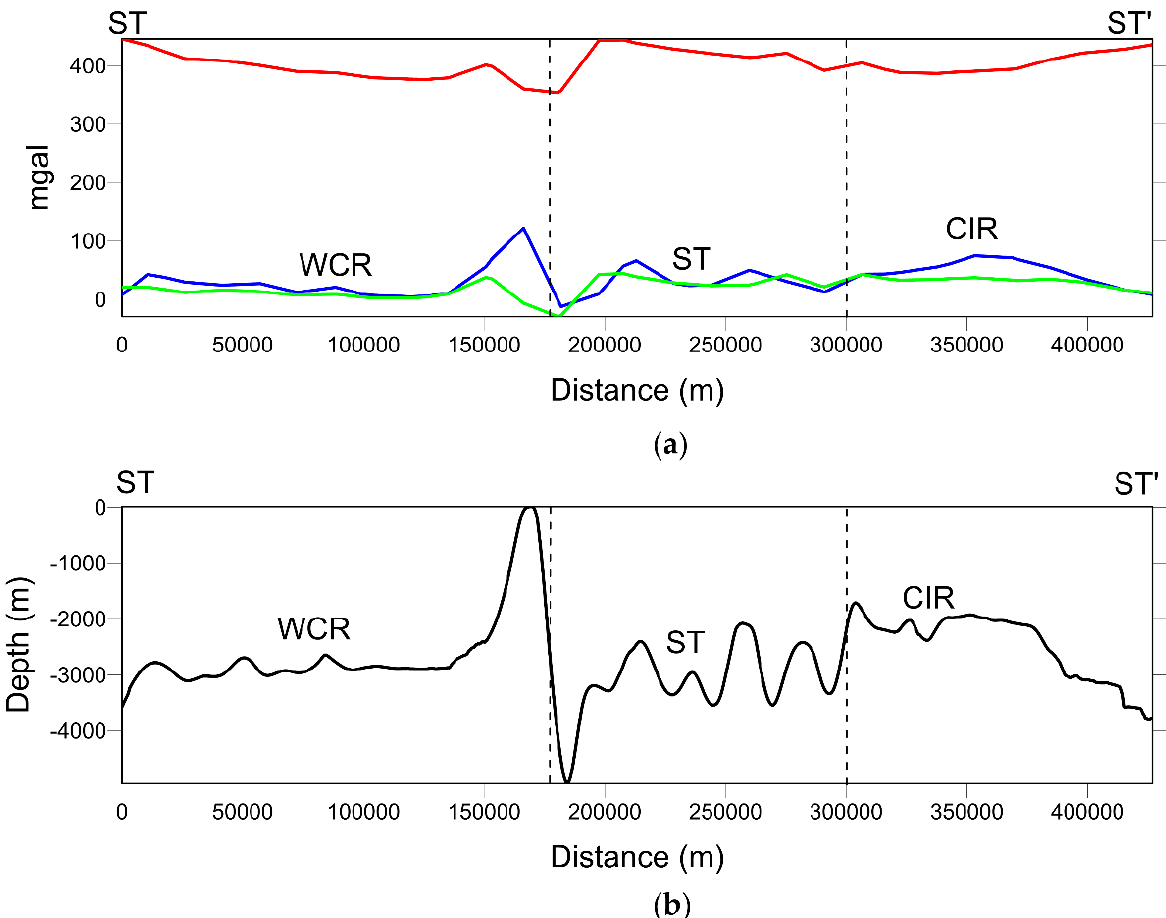
Figure 10. The comprehensive geophysical characteristics across the Sorol Trough. ( a ) Gravity anomaly profiles STST’ (Red = Bouguer gravity anomaly, Blue = free-air gravity anomaly, Green = isostatic gravity anomaly); ( b ) bathymetric profile STST’. The profiles are extracted from the line segment STST’ across the ST as shown in Figure 1. See Figure 1 for abbreviations.